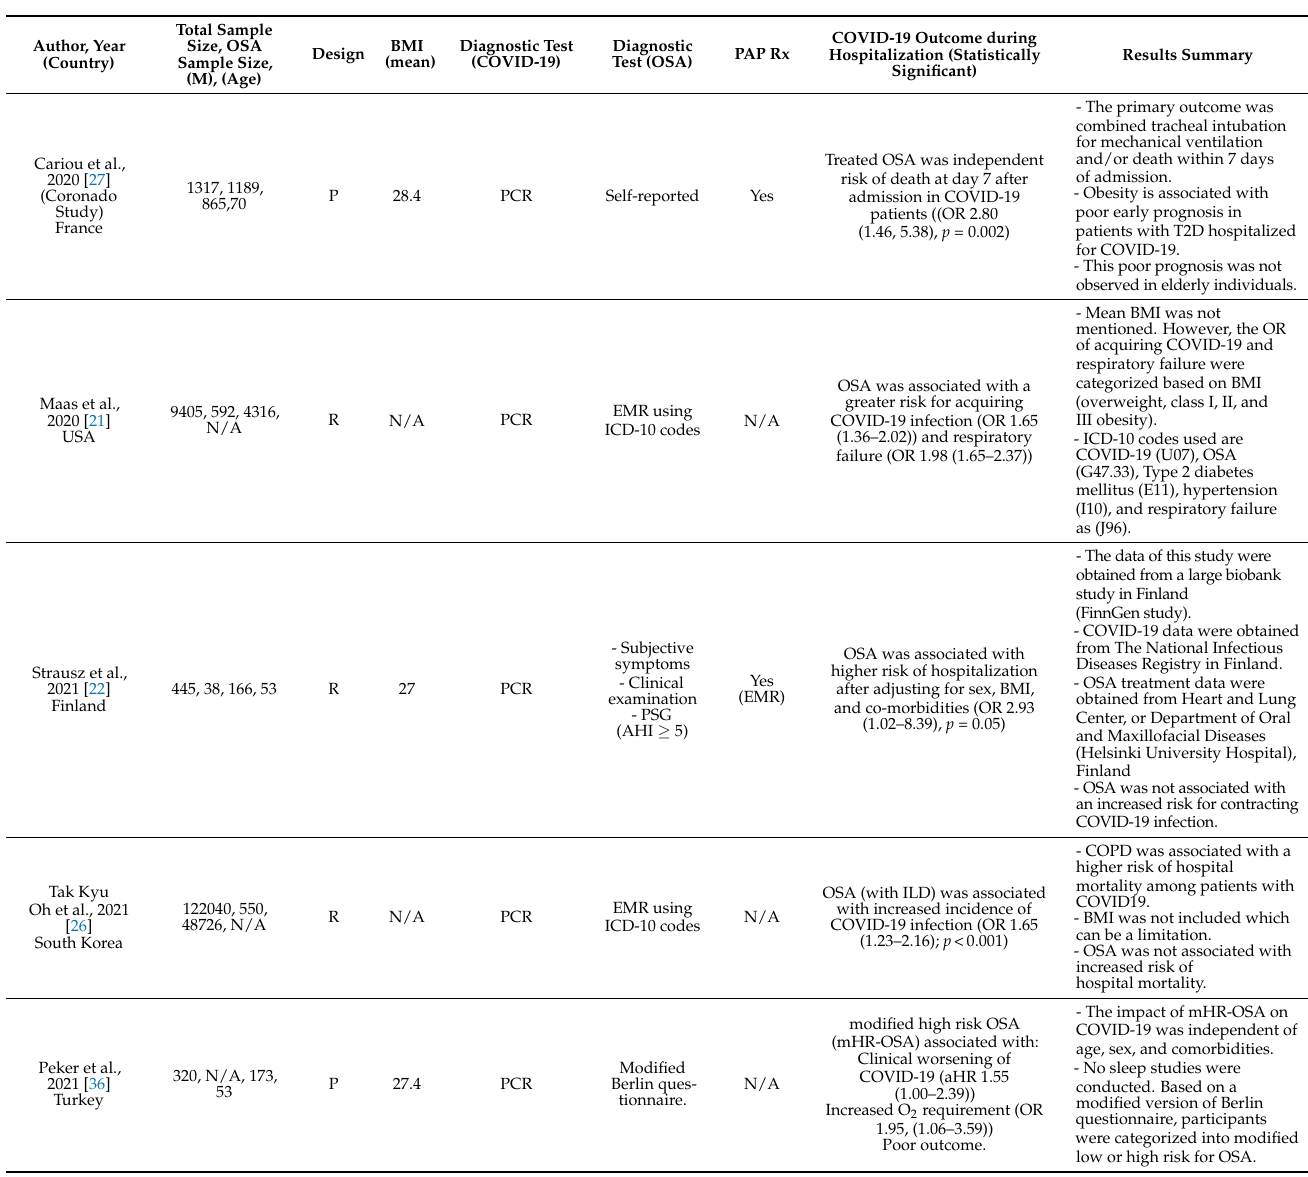
Table 1. The impact of obstructive sleep apnea on COVID-19 outcome in hospitalized patients with COVID-19